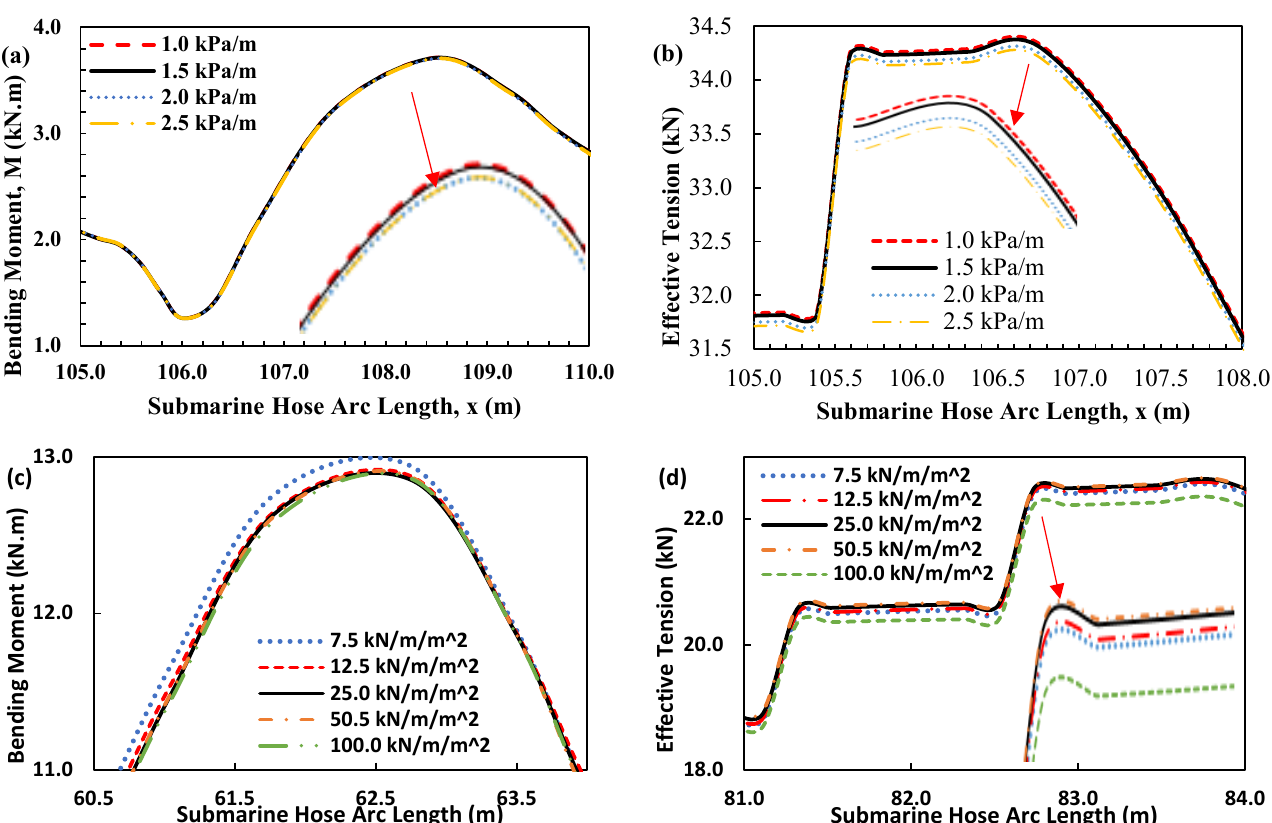
Figure 35. Influence of soil shear strength gradient and soil stiffness on submarine hoses. ( a ) Bending Moment for soil shear strength gradient. ( b ) Effective tension for soil shear strength gradient. ( c ) Bending Moment for soil stiffness. ( d ) Effective tension for soil stiffness.